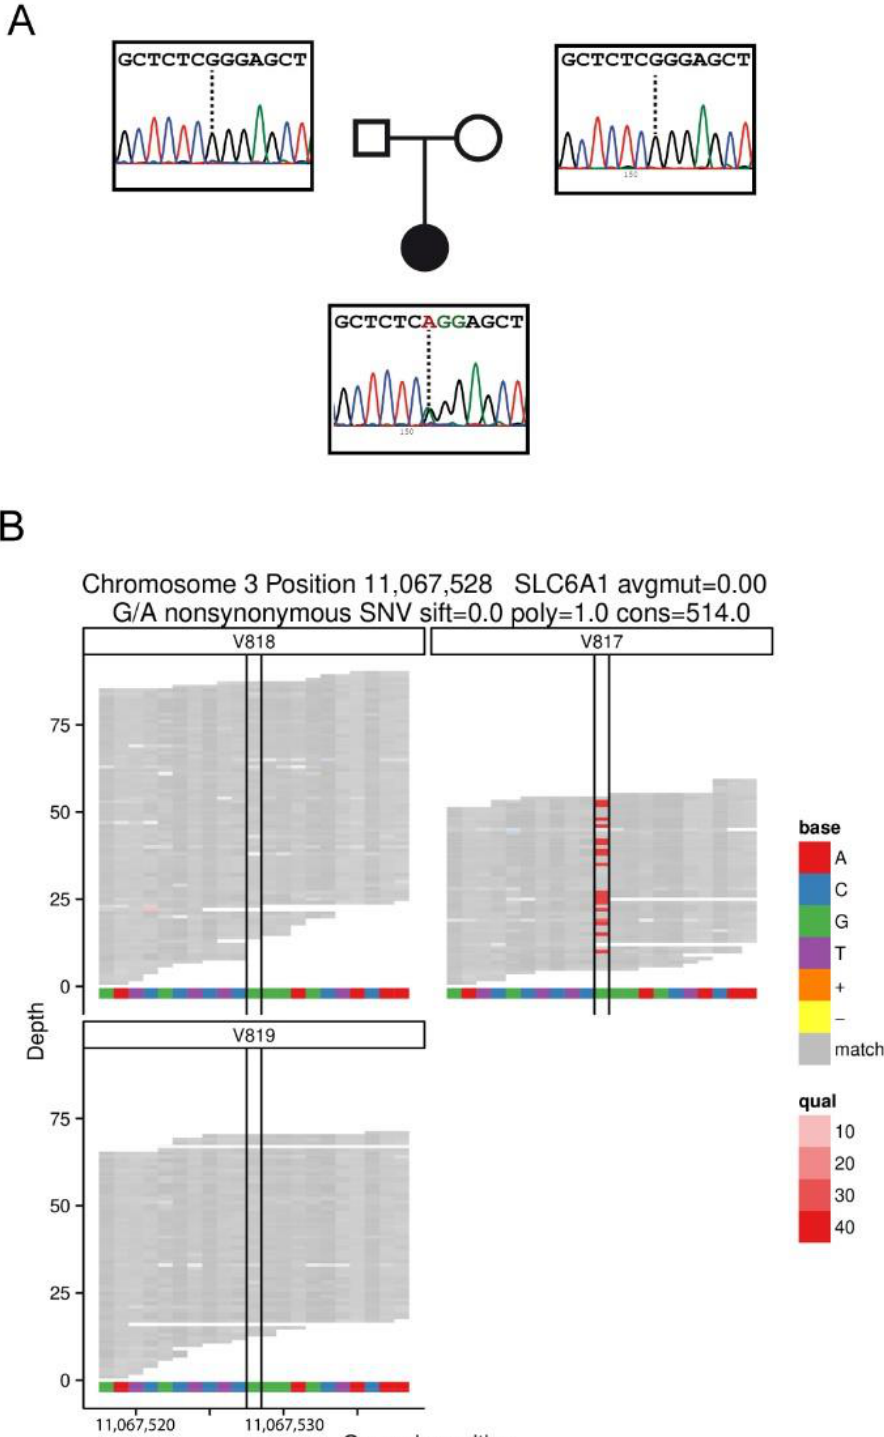
Figure 1. ( A ) Pedigree and Sanger sequencing of the family 1 trio. ( B ). Integrated genomics viewer (IGV) screenshot from WES coverage data of point mutation c.919G>A (p.Gly307Arg) in trio family from patient 1 (genomic location chr3:11067528; V817 index case; V818 father; V819 mother). Patient 2 was a 2.5-year-old Spanish Caucasian boy with no family history of neuro- developmental disorders. He was born by cesarean section at 37 weeks of gestation due to vasa previa after a normal pregnancy, with a birth weight of 2860 g. He was referred to the clinic at 9 months old due to psychomotor delay with generalized hypotonia and poor social contact. He also had sleep disturbances and refused solid food. Neurologic exami- nation revealed no dysmorphic features, poor visual contact, impaired social interaction and midline stereotypies, such as handwashing or hand interlocking. He had a general- ized hypotonia, including inability to sit independently and absence of the Landau reflex. At 15 months of age, daily episodes of ocular elevation and possible disconnection were observed. Brain magnetic resonance imaging did not show abnormalities. EEG was abnormal due to a slower background rhythm and frequent occipital bursts of delta waves along the entire tracing, with interspersed occipital spike-wave activity. The episodes dis- appeared after VPA treatment, although the slow occipital delta activity persisted on the EEG. At 22 months, clobazam was added due to the appearance of palpebral myoclonus and 3 – 4-min lasting absences. Thereafter, he had no new paroxysmal episodes. Currently, at the age of 4, he is at a motor level where he can walk independently, though ASD features persist, with behavioral disorder, motor stereotypes and no lan- guage. Consequently, a diagnostic exome sequencing for epileptic encephalopathies (Bioar- ray, 543 genes) was requested. Results revealed the same mutation in gene SLC6A1 as in patient 1 (NM_003042.3: c.919G>A; NP_003033.3: p.Gly307Arg). A trio-based WES also